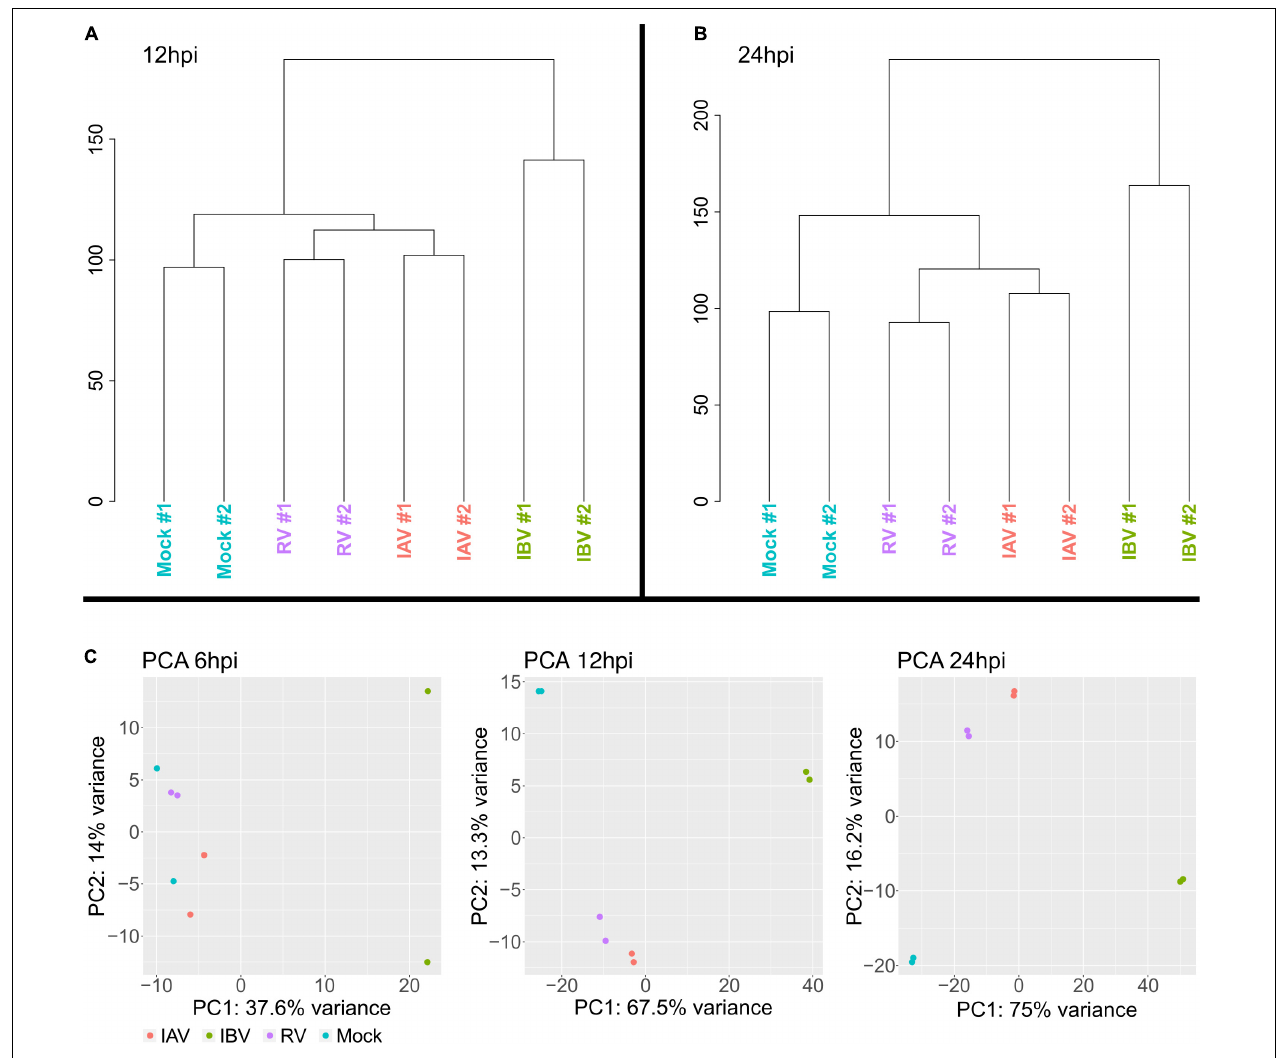
FIGURE 2 | Hierarchical clustering of gene expression for (A) 12 hpi time point and (B) 24 hpi time point showing a distinct gene expression for IAV, IBV, and RV. (C) Principal component analysis for 6, 12, and 24 hpi.